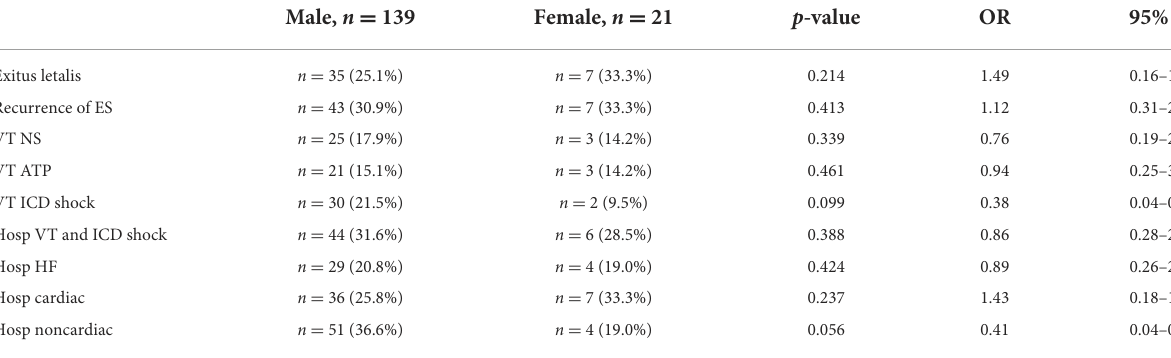
TABLE 2 Analysis between male vs. female.